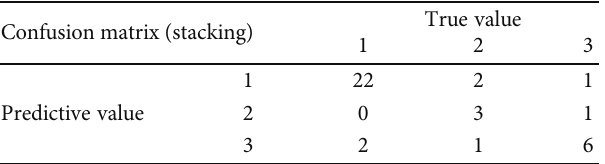
Table 8: Confusion matrix of optimized Stacking integration model for predicting ROP level.